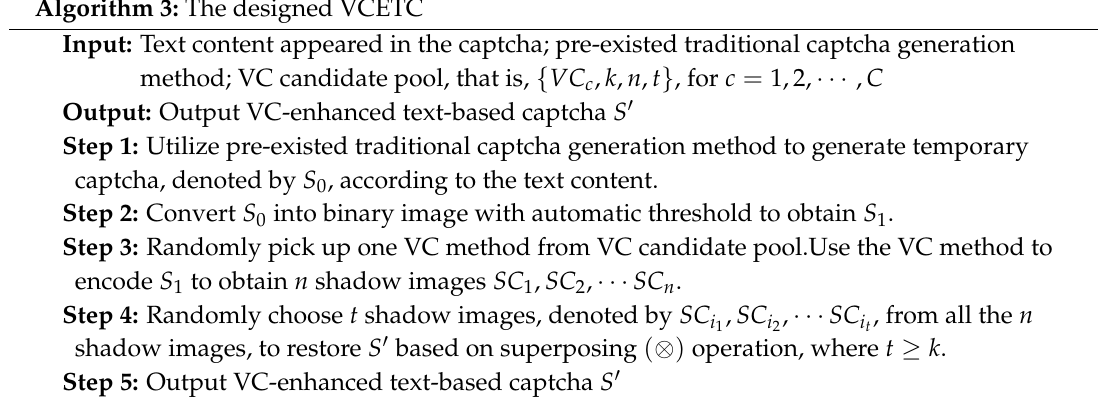
Algorithm 3: The designed VCETC